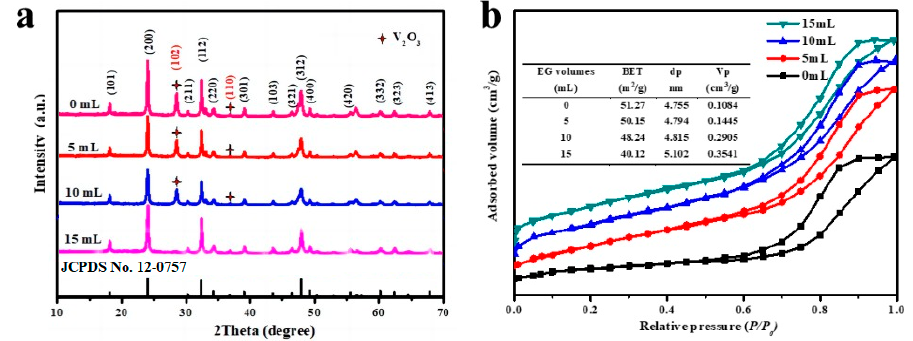
Figure 1. XRD pattern ( a ); N 2 adsorption–desorption isotherm curve of different samples ( b Figure 1. XRD pa tt ern ( a ); N 2 adsorption–desorption isotherm curve of di ff erent samples ( b ).